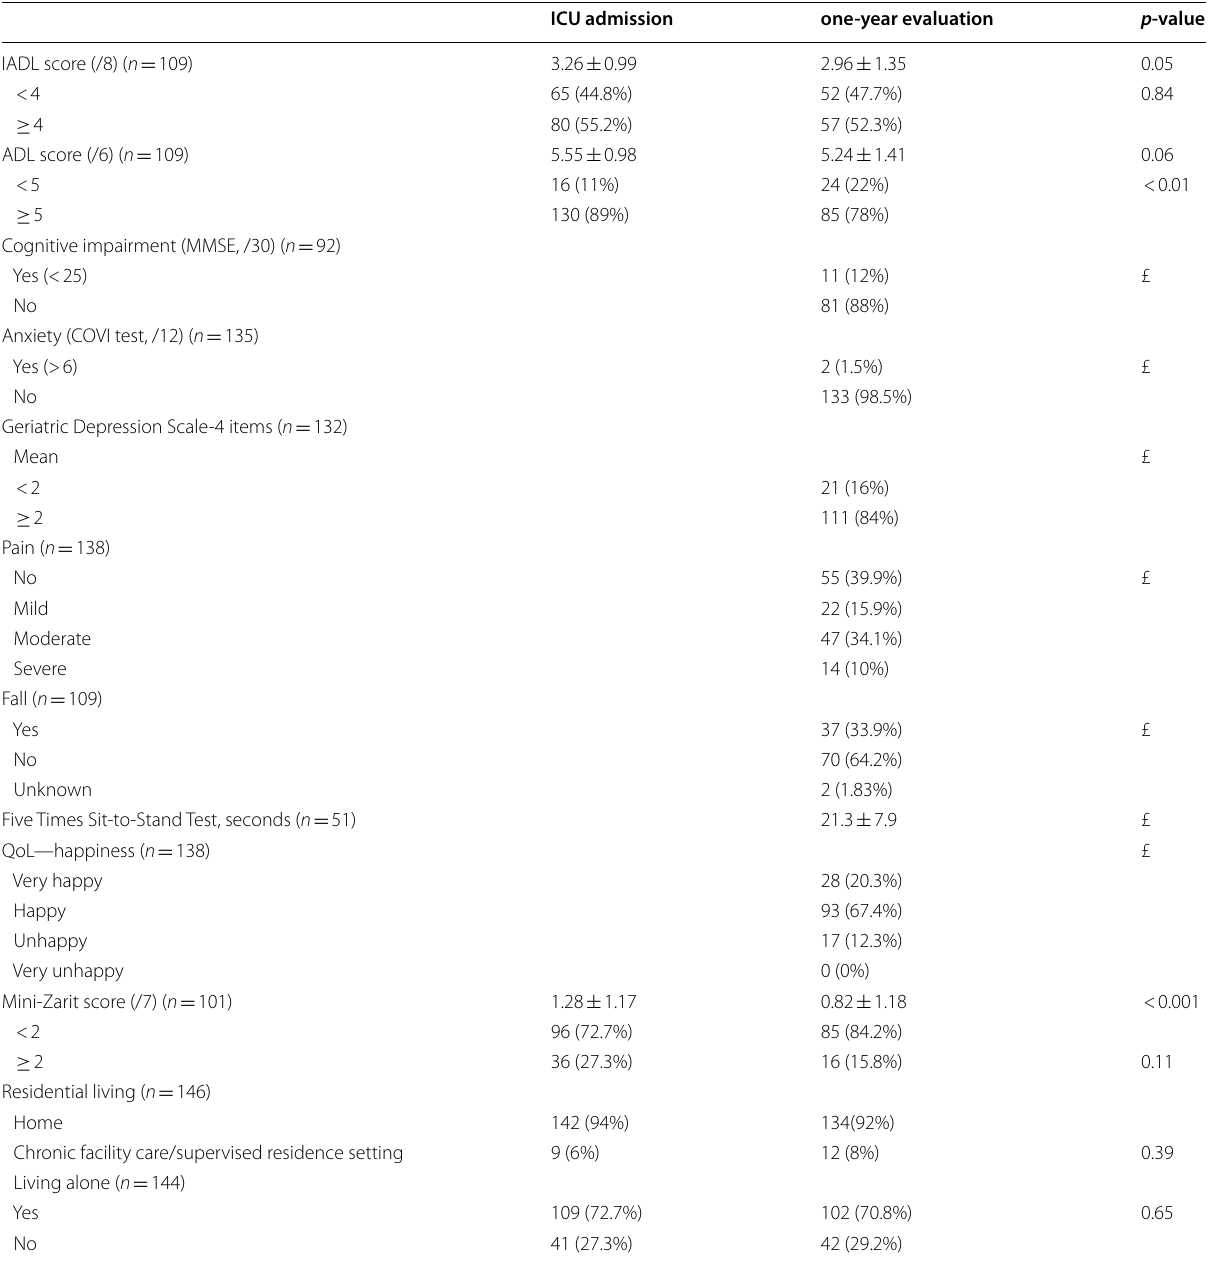
Table 3 Characteristics of survivors after 1 year of